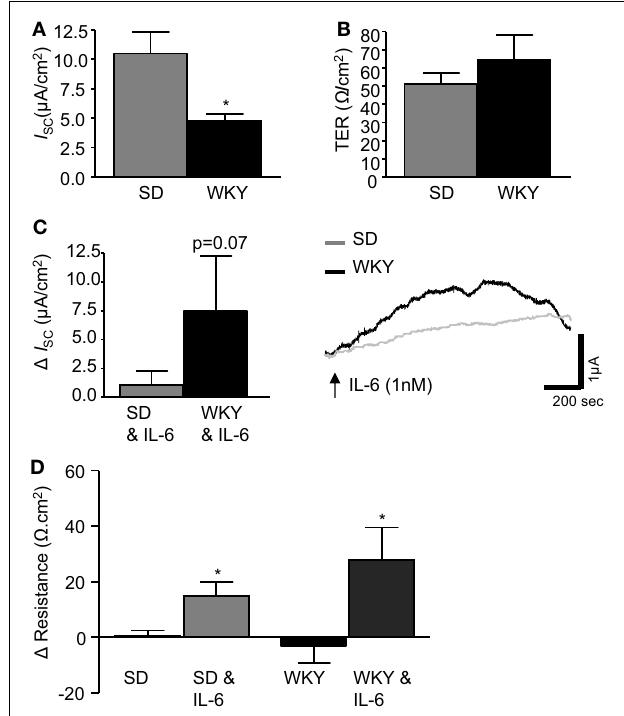
FIGURE 1 | IL-6 modulates transepithelial current and resistance. (A) The histograms illustrates basal short circuit current ( I SC , µ Acm 2 , SD: n = 18,WKY: n = 9) and (B) transepithelial resistance (TER, Ω cm 2 , SD: n = 17,WKY: n = 8) in distal colon segments from naïve Sprague Dawley (SD) andWistar Kyoto (WKY) rats. (C) The histograms and representative trace shows the effect of basolaterally applied IL-6 (1nM, measured 10min after application) on basal I SC (SD: n = 23,WKY: n = 9). (D) This histogram illustrates the change ( ∆ ) in tissue resistance over the course of the experiment (60–90min, SD: n = 18,WKY: n = 6).Values = mean ± SEM. * Indicates p <